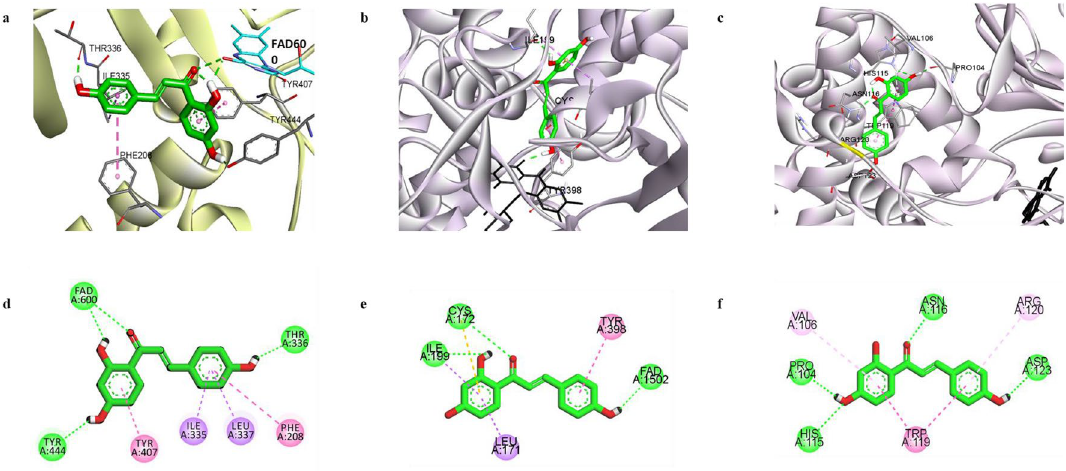
Figure 3. The docking pose of isoliquiritigenin (ILG) (green) at the catalytic binding site of hMAO-A ( a ). The docking poses of ILG at the catalytic ( b ) and allosteric ( c ) binding sites of hMAO-B. Key interaction molecules involved in catalytic site binding of hMAO-A ( d ) and hMAO-B ( e ) and at the allosteric site of hMAO-B ( f ) are represented by a two-dimensional binding diagram of ILG. H-bond, pi-pi-stack, pi-pi T-shaped, pi-sigma, and pi-alkyl interactions are shown with green, dark pink, violet, and light pink dashed lines,